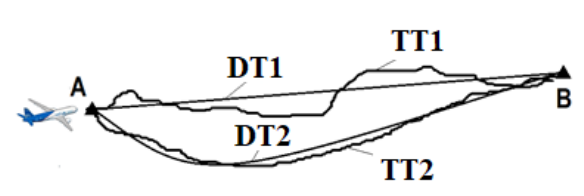
Fig.1. True track for various errors of track